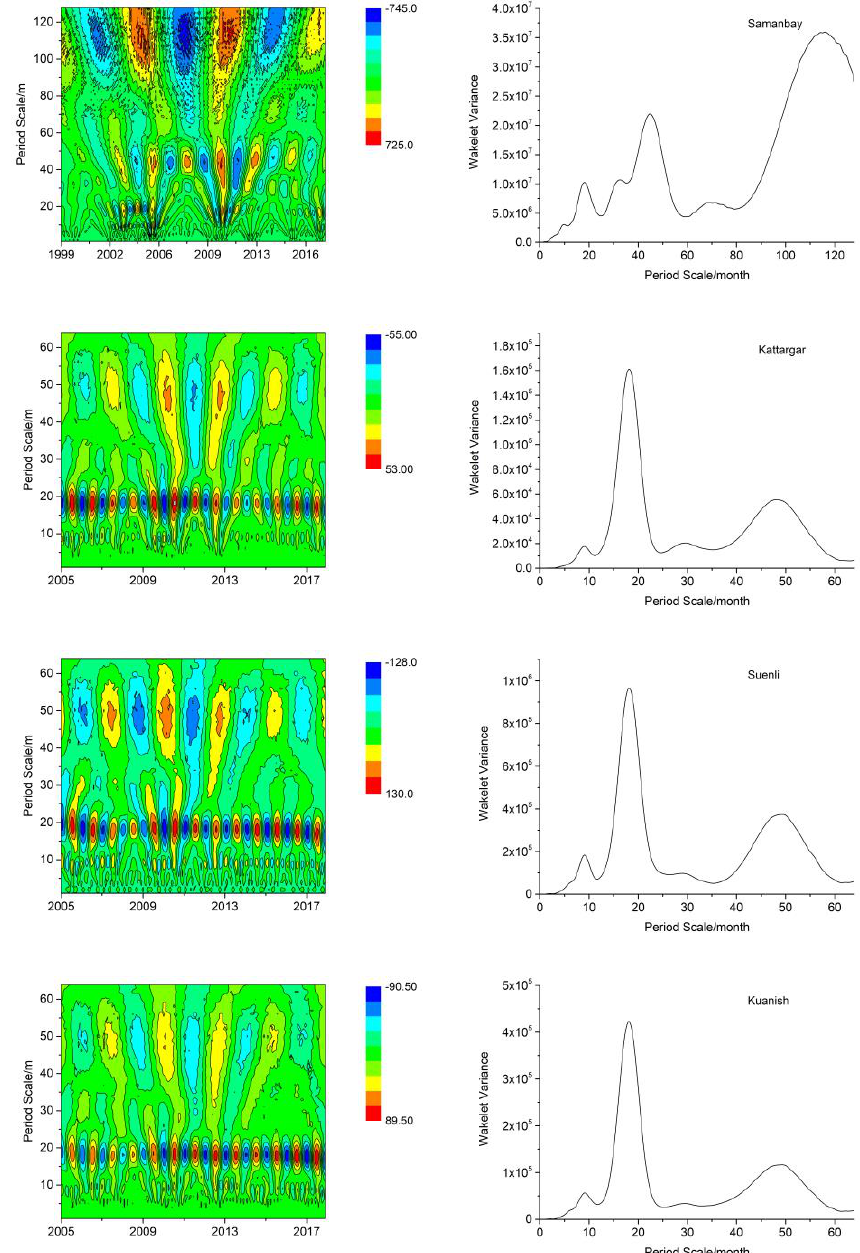
Figure 9. Monthly average runoff and irrigation water wavelet coefficient real part contour figure and wavelet variance figure.